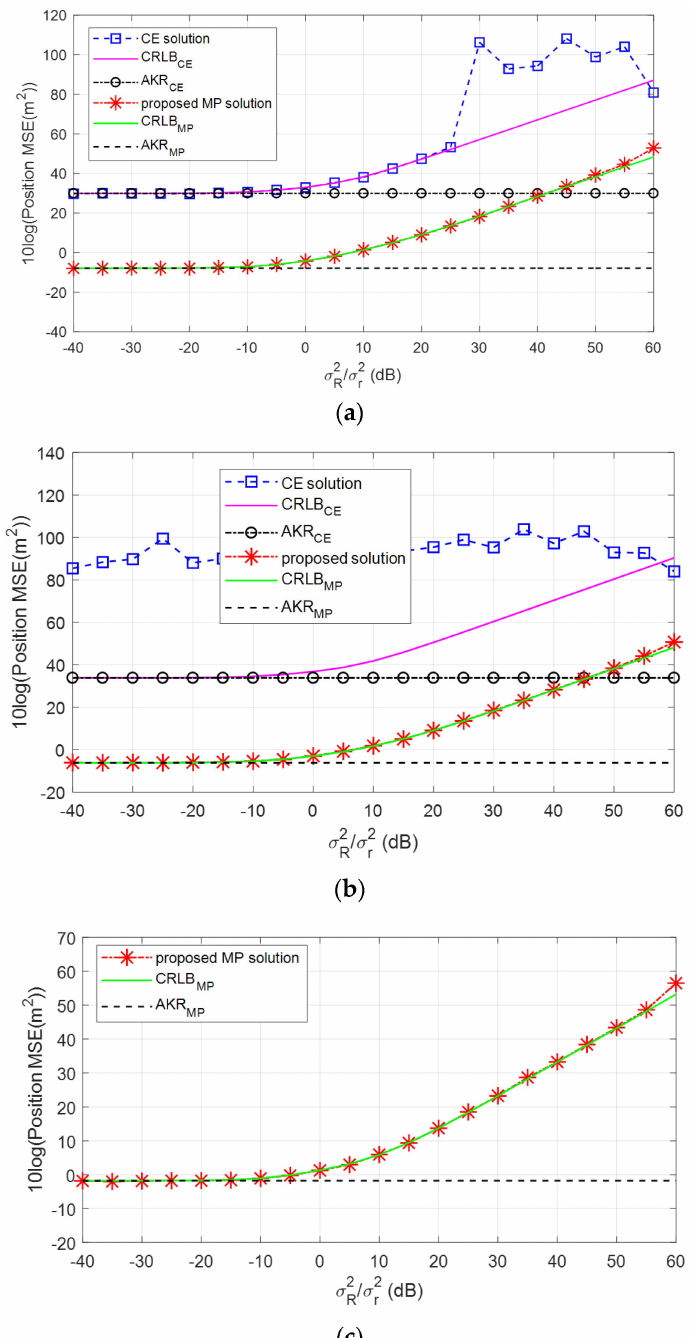
Figure 7. Performance with different numbers of sensors: ( a ) 5 sensors, ( b ) 4 sensors, ( c ) 3